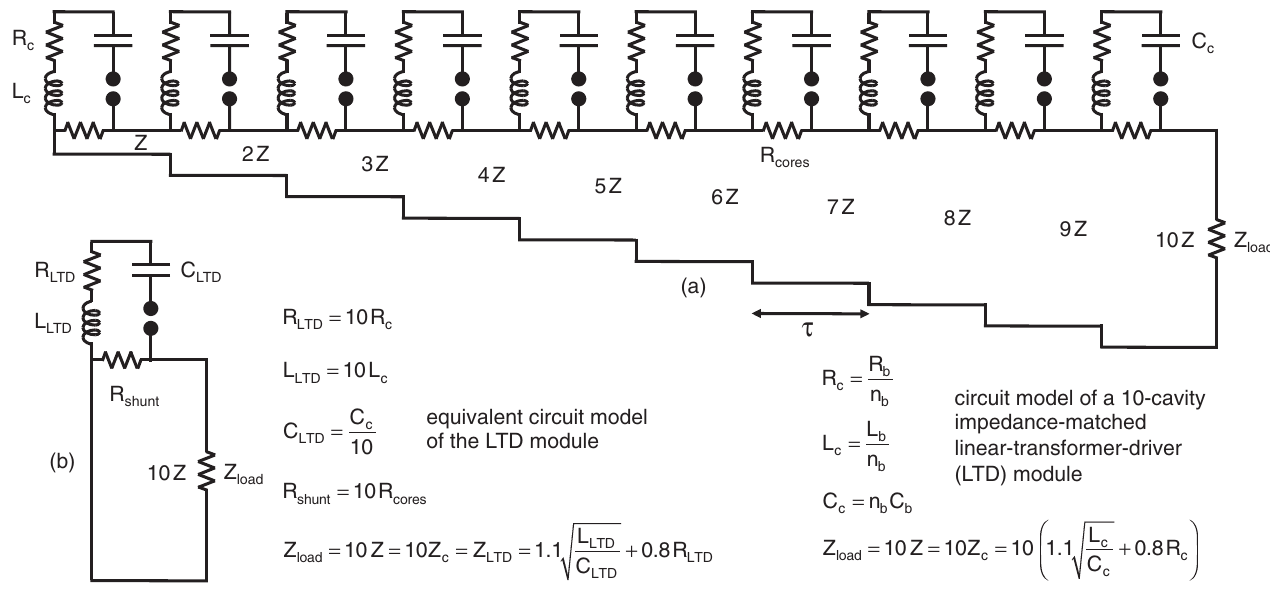
circuit model of a 10-cavity impedance-matched